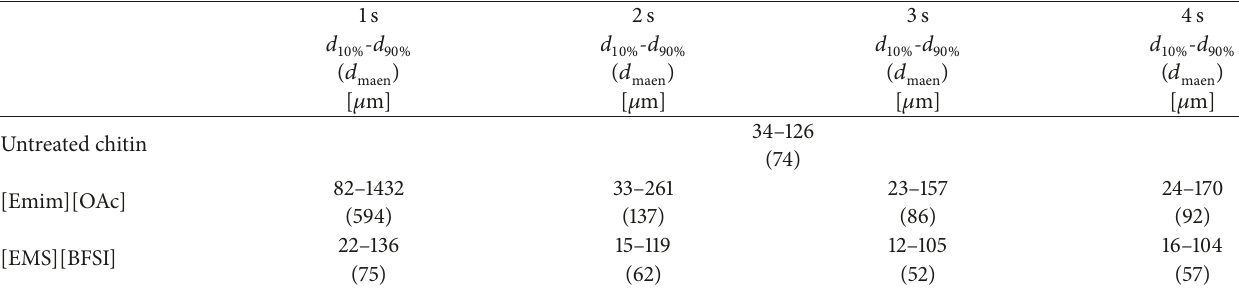
Table 2: Mean size of chitin particles and particle size distribution.